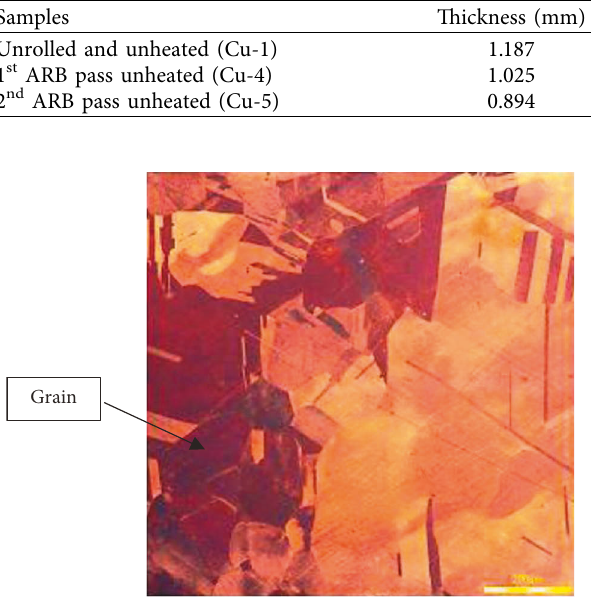
Figure 2: Optical microscope micrograph of parent sample at 277X (Cu-1).